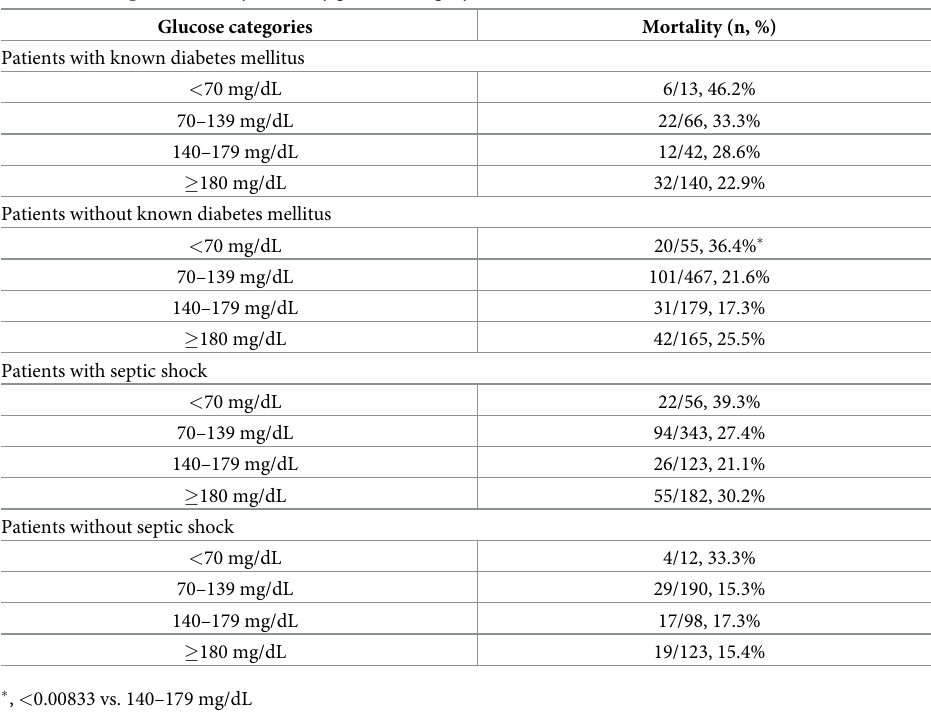
Table 3. In-hospital mortality and body glucose category on admission.